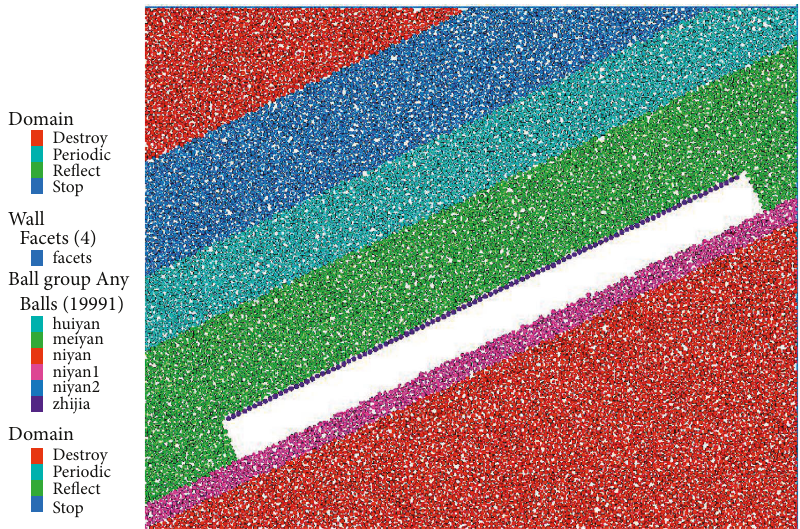
Figure 2: Trend model of the 9-301 working